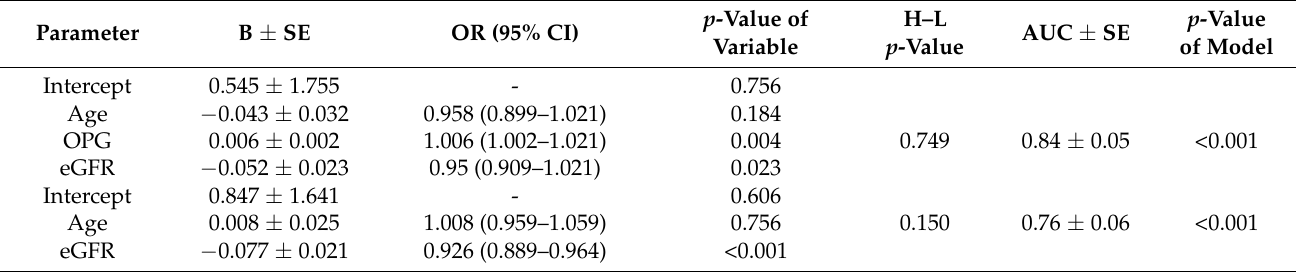
Table 3. Markers associated with anaemia in chronic kidney disease patients based on a logistic regression model.